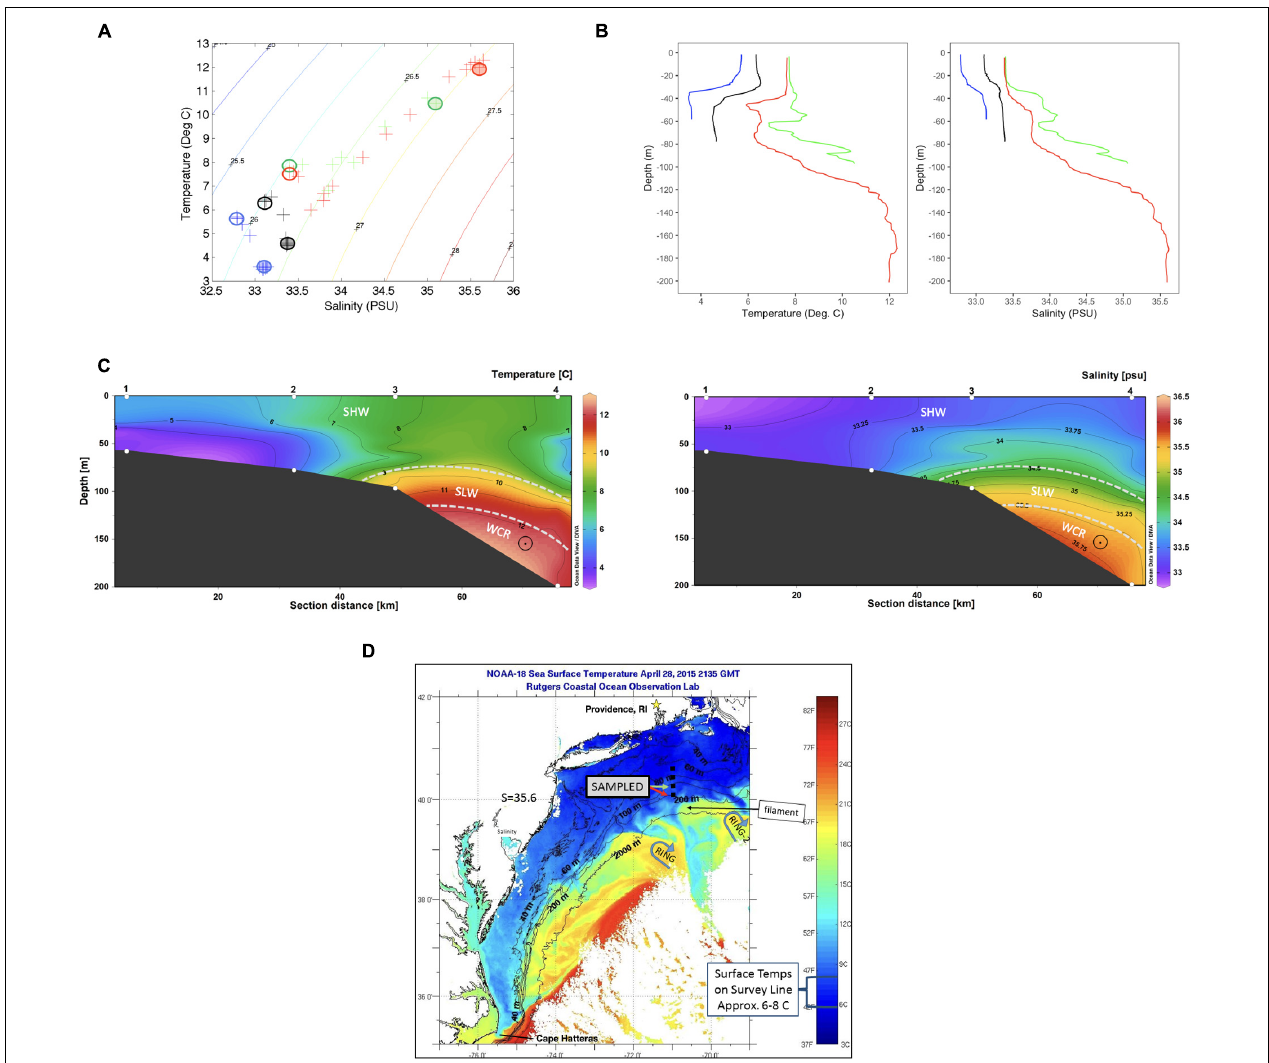
FIGURE 1 | (A) A temperature/salinity plot identifying water mass characteristics from the four stations. Sampling locations indicated by circles, filled circles bottom and empty circles surface waters. (B) Temperature (left) and salinity (right) profiles at each station (data from CTD). Blue: Stn. 1; Black: Stn. 2; Green: Stn. 3; Red: Stn. 4. (C) Vertical contour of temperature and salinity over the sampling transect, with water masses sampled indicated by dashed lines. SHW, Shelf water; SLW, Slope water; WCR, Warm core ring intrusion. (Plot produced with Ocean Data View, Schlitzer, 2016). (D) Satellite imagery of sea surface temperature on April 28, the day Stns 3 and 4 were sampled. Stations surveyed are indicated by black squares. Two warm core rings near the survey sites are indicated by blue arrows, and a warm filament being pushed onto the continental shelf where Stn. 4 bottom waters are sampled is indicated.